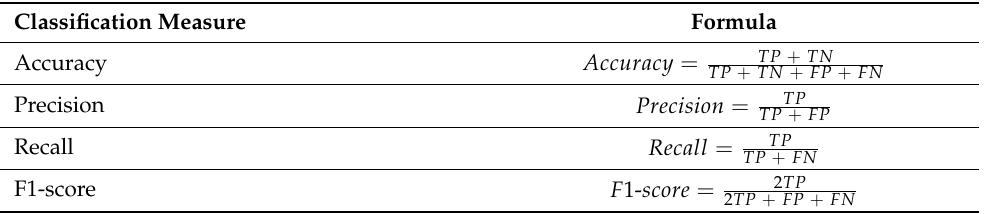
Table 3. The classification measures used to evaluate the proposed intelligent ensemble learning approach for phishing website